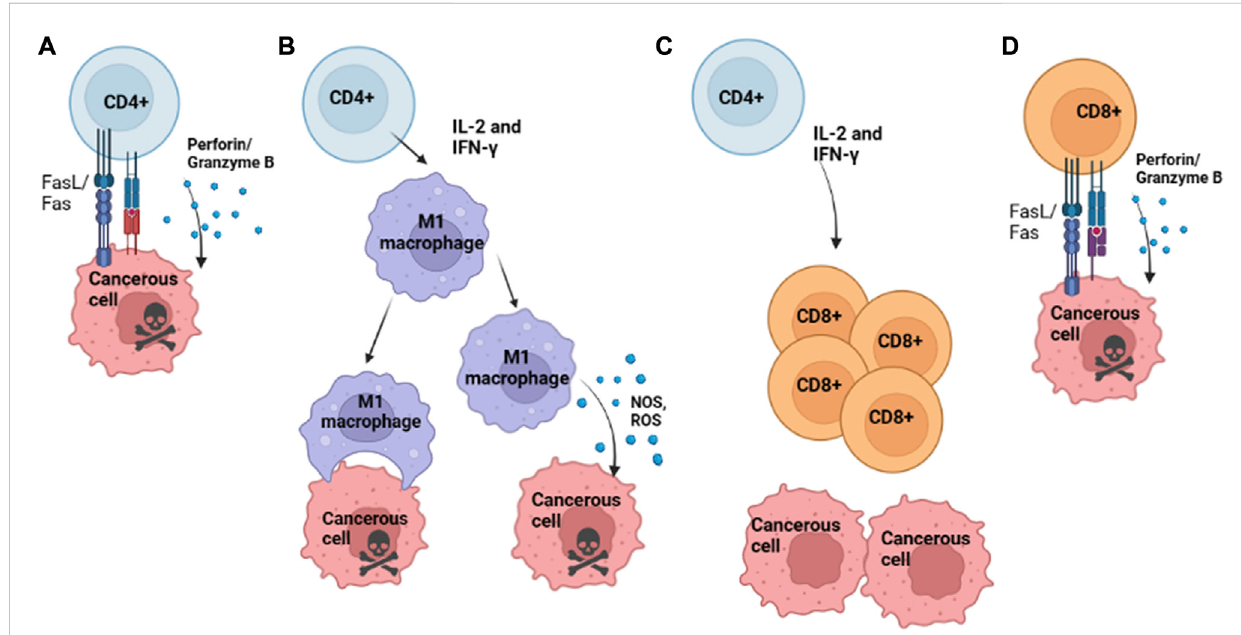
FIGURE 1 Conventional Mechanisms of T Cell Anti-Tumoral Activity. (A) Th1 differentiated CD4 T cell killing of cancerous cells that present neoepitopes on MHC II via secretion of perforin and granzyme B. (B) CD4 T cells release cytokines IL-2 and IFN- γ to recruit M1 macrophages; activated M1 Macrophages can kill cancerous cells either by direct phagocytosis or release of NOS or ROS, which results in tumor cell death and continue to secrete IL-12, among othercytokineswhichrecruitTcellstothesiteofthetumor. (C) ActivatedCD4TcellreleaseofcytokinessuchasIL-2andIFN- γ ,whichrecruitsCD8 T cells to the site of tumor growth. (D) CD8 T cells directly kill cancerous cells that present neoepitopes via MHC I via the Fas/FasL and the release of perforin/ granzyme B, resulting in tumor cell killing. Image Created with